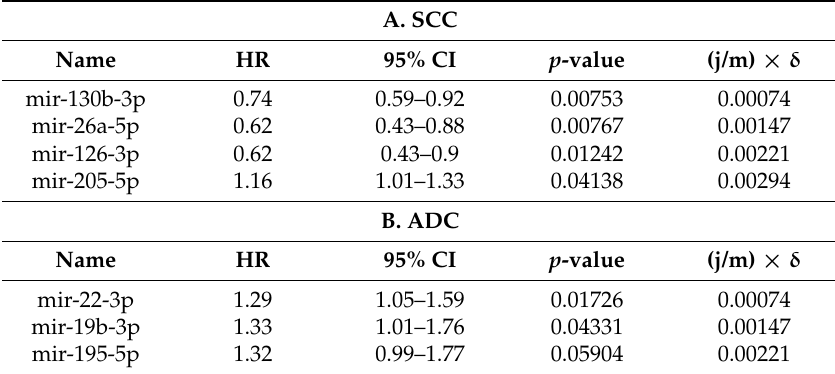
Table 4. miRNAs significantly associated with overall survival (OS) at univariable